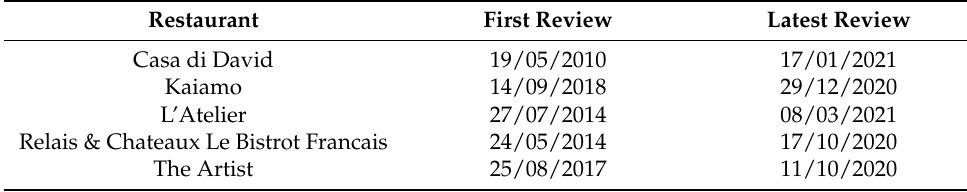
Figure A1. Total number of reviews per month. Table A1. The distribution of reviews per restaurant.